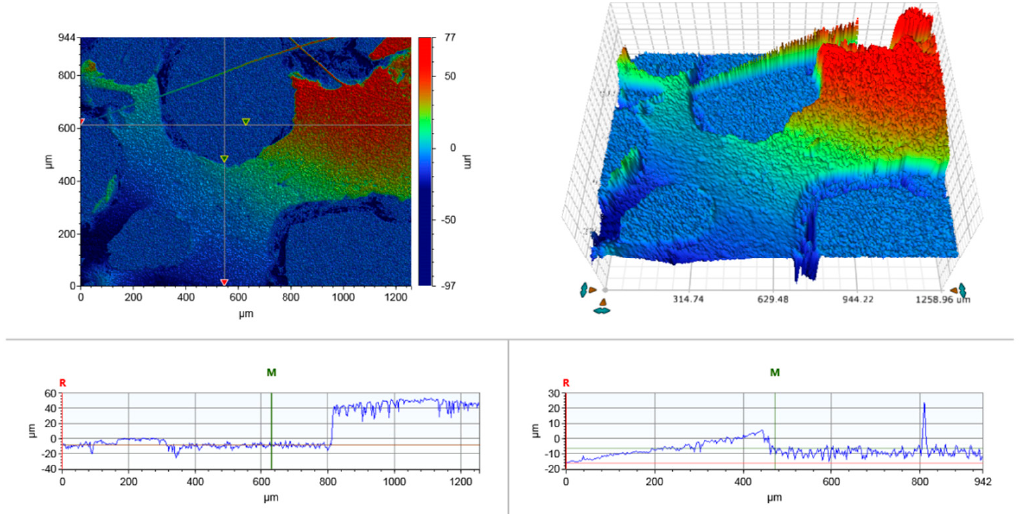
Figure 3. The 3D images of AESO foam reinforced with 2% cellulose fibres. Table 1. The porosity, volumes and density of the pristine AESO and cellulose-reinforced AESO foams. Samples